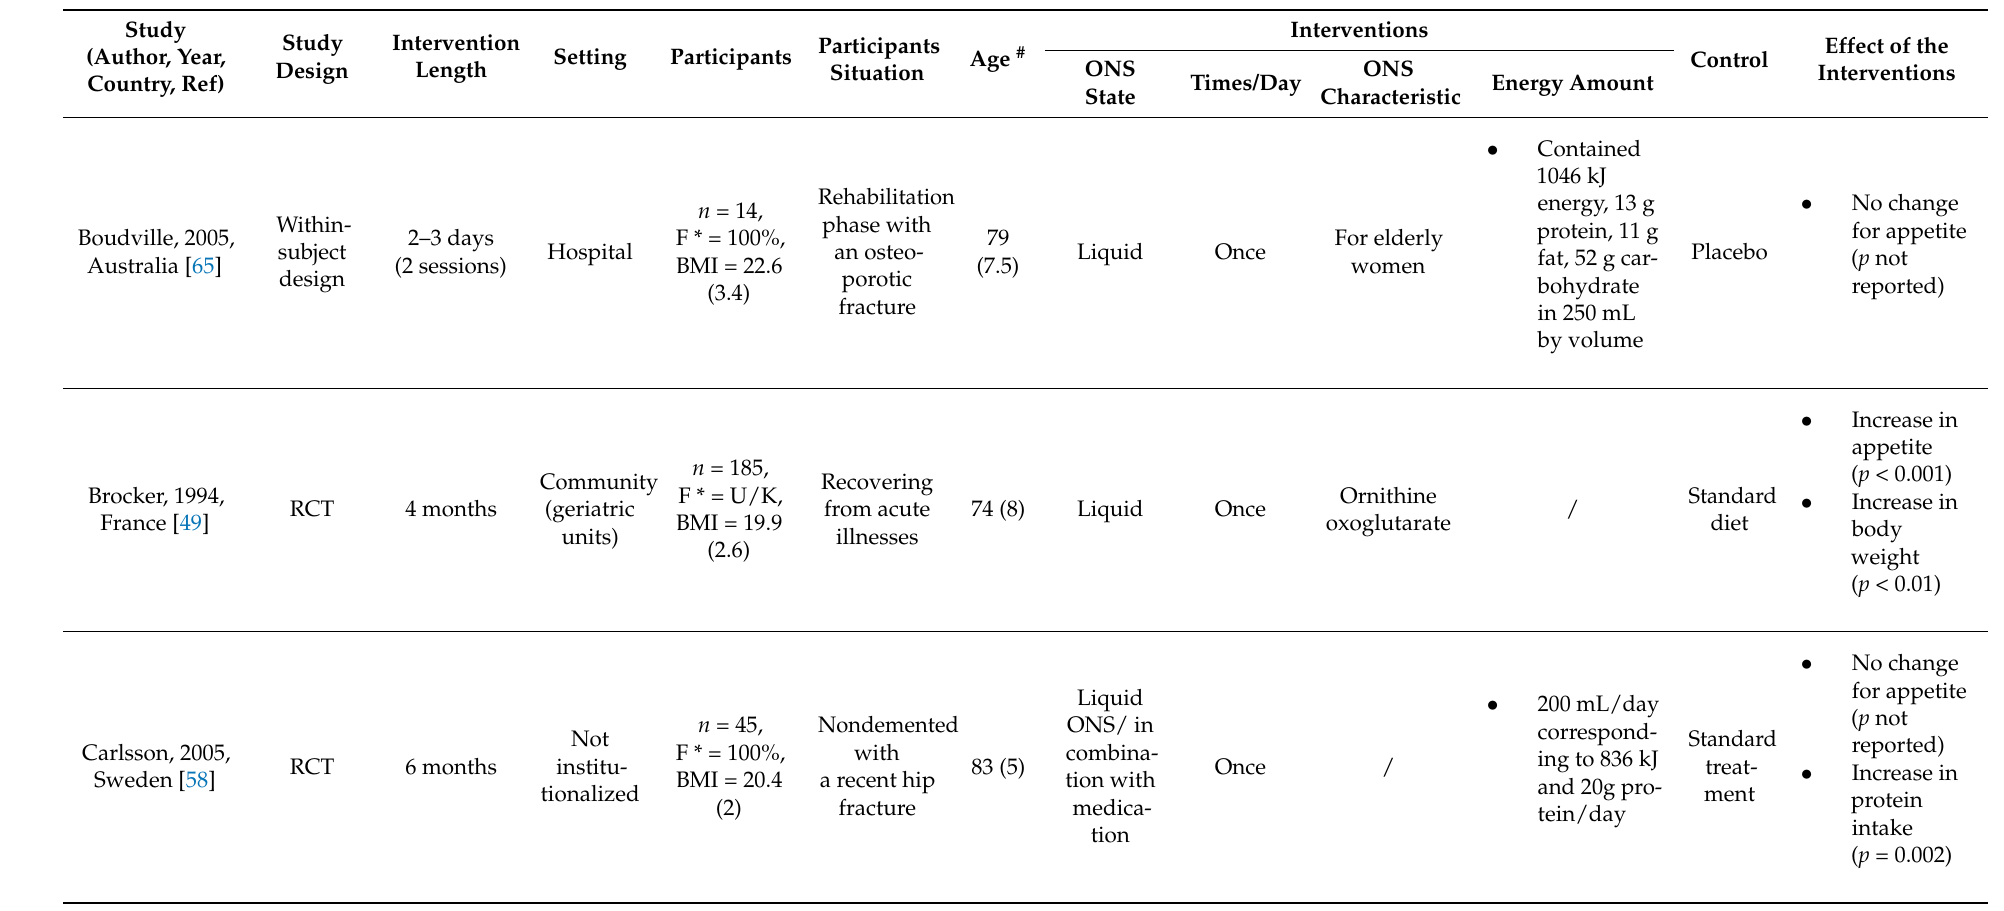
Table 2. Summary of the included